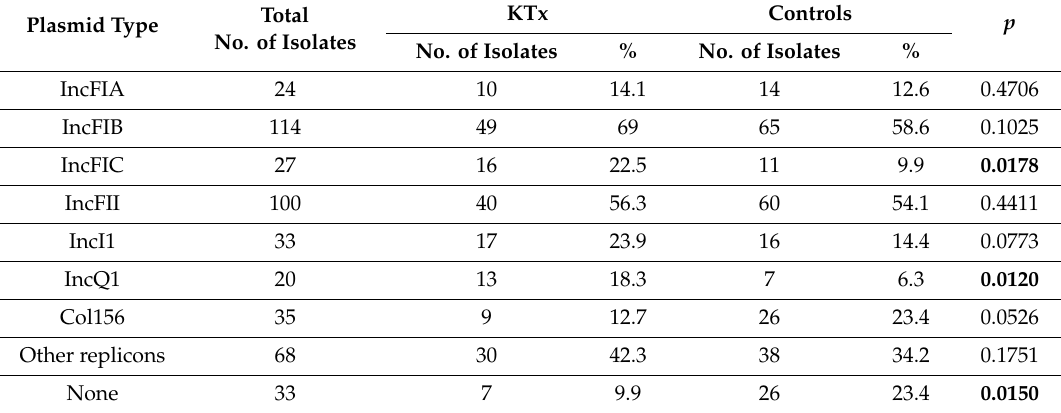
Table 6. Distribution of the most frequent plasmid replicon types in relation to KTx and control UPEC